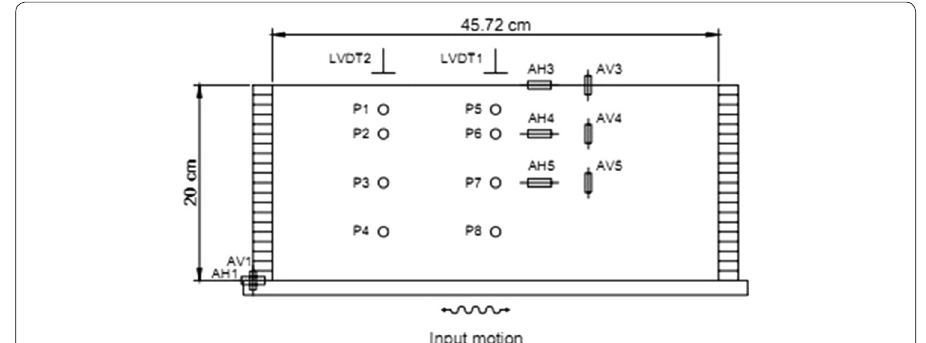
Fig. 1 Cross section view of centrifuge experiment No. 1 [23]